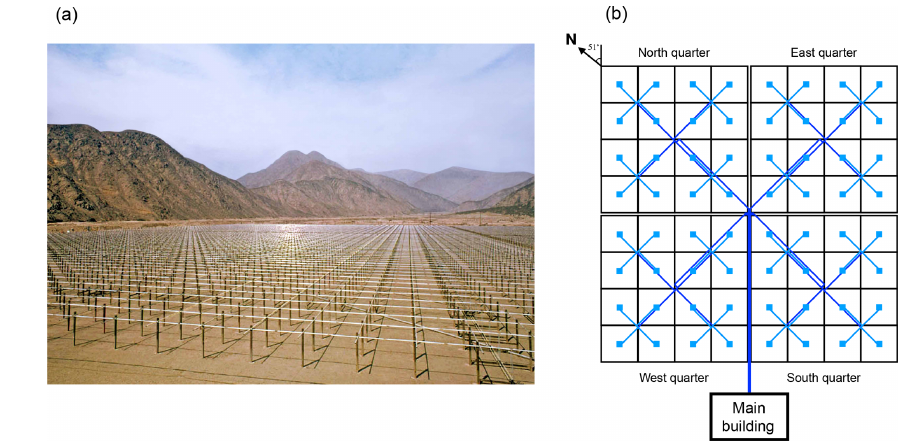
Figure 9. (a) A picture of the main antenna array at JRO, which is one of the largest antennas in the world (picture taken by Ken Bowles). (b) A diagram of the antenna connections. The main array is divided into quarters, and each of them is composed of 16 antenna modules, making a total of 64 modules.